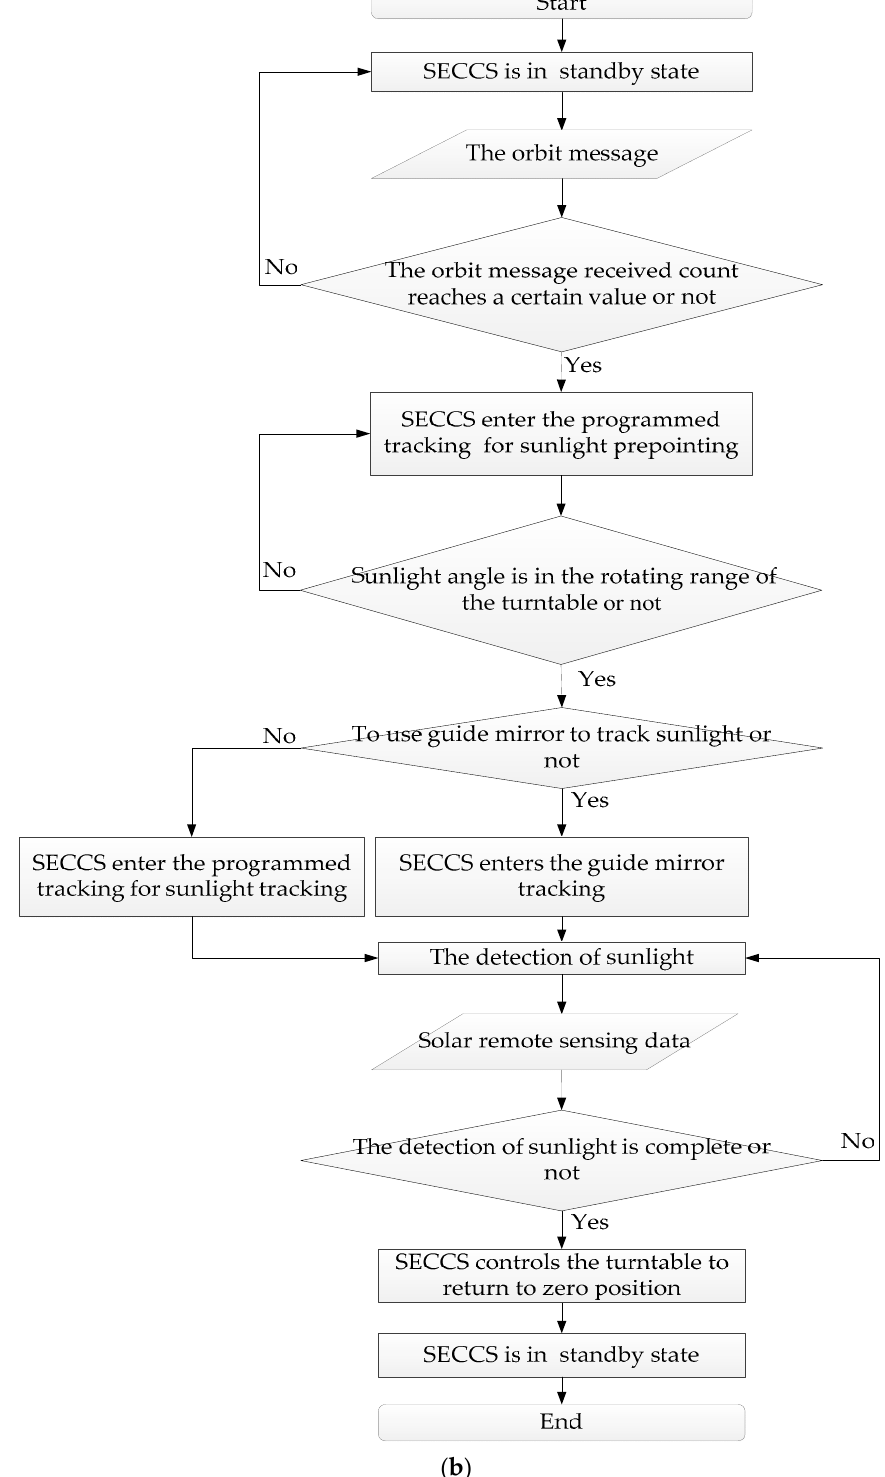
Figure 2. ( a ) Working-principle diagram of the instrument. ( b ) Turntable control flow. The spectrometer’s electrical cabinet receives the broadcast message (satellite attitude) and the orbit message (solar vector, etc.) sent by the satellite through the 1553B bus. With these data and the mechanical installation correction parameters, the azimuth and pitch angles of the solar radiation in the guide-mirror coordinate system are calculated by soft- ware in real time. On one hand, these angles are used to measure the time it takes for the